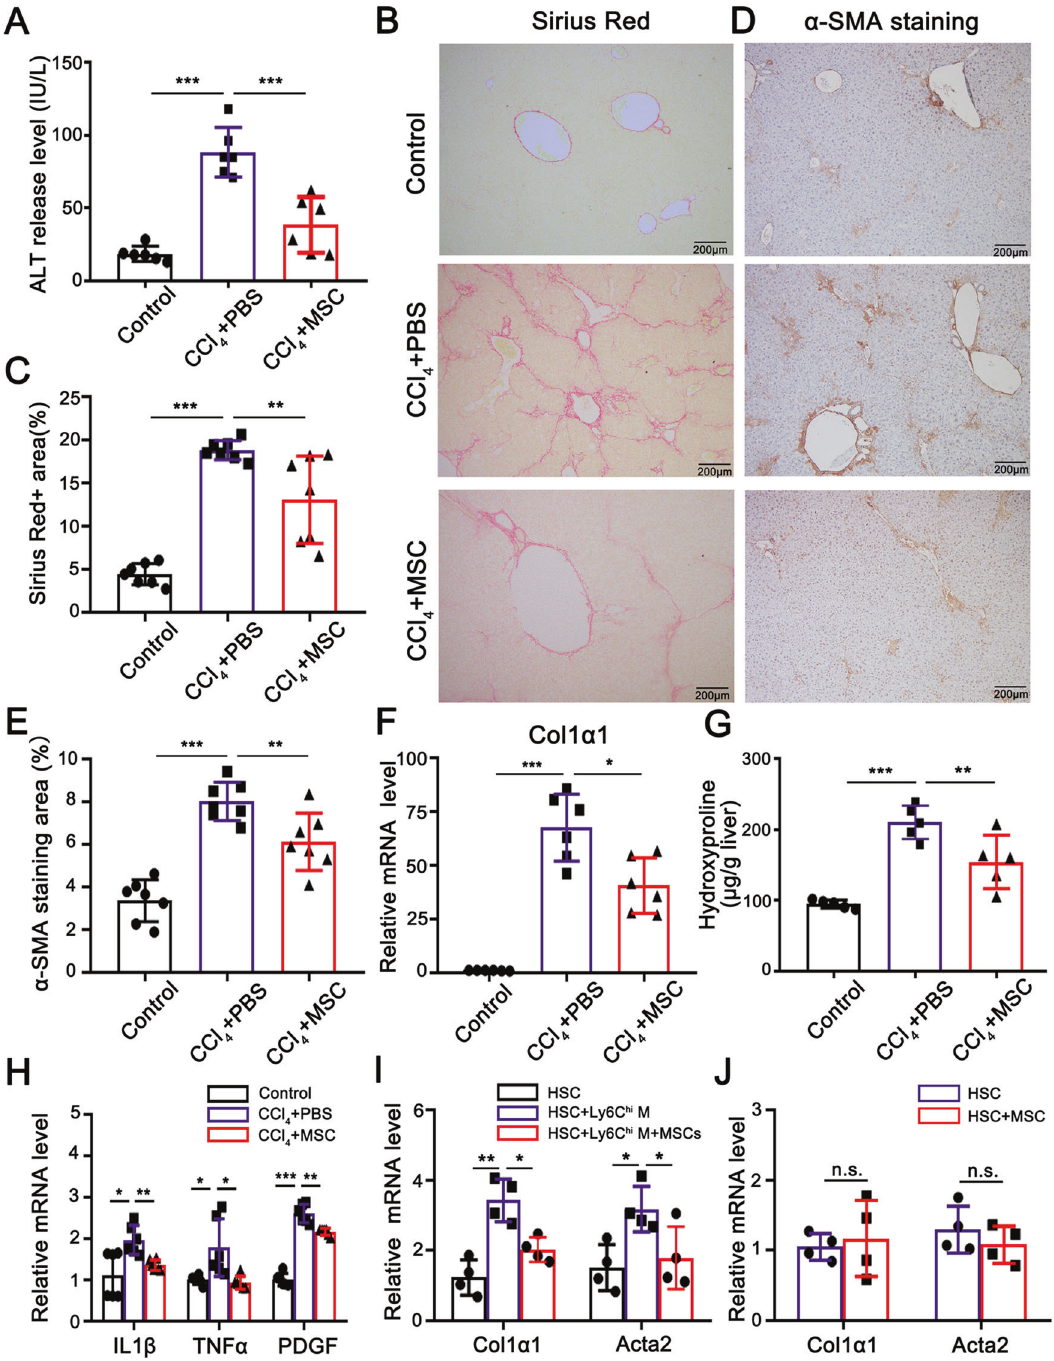
Fig. 1 BM-MSC transplantation attenuated CCl 4 -induced in fl ammatory levels and liver fi brosis. A ALT release level in the serum of normal control mice and fi brotic mice transplanted with BM-MSCs or PBS (control). Serum samples were collected at 2 weeks post-transplantation ( n = 6). B , C Liver tissue sections were stained with Sirius Red ( B ), and the degree of liver fi brosis was semi-quanti fi ed by Image software ( C ) ( n = 7). Scale bars, 200 μ m. D , E Immunohistochemistry staining of α -SMA in each group ( D ) and α -SMA + areas were semi-quanti fi ed by Image software ( E ) ( n = 7). Scale bars, 200 μ m. F Quanti fi cation of col1 α 1 mRNA expression levels related to GAPDH by quantitative real-time PCR ( n = 6). G Examination of hydroxyproline contents in livers at 2 weeks post-transplantation of BM-MSCs ( n = 5). H Relative expression levels of il- 1 β , tnf- α , and pdgf mRNAs in livers of normal control and fi brotic mice transplanted with BM-MSCs or PBS examined by quantitative real-time PCR ( n = 6). I Relative expression levels of col1 α 1 and acta2 mRNAs in HSCs, HSCs cocultured with Ly6C hi macrophages, and HSCs cocultured with Ly6C hi macrophages plus BM-MSCs examined by quantitative real-time PCR ( n = 4). Ly6C hi M is the abbreviation of Ly6C hi macrophages. J Relative expression levels of col1 α 1 and acta2 mRNAs in HSCs cocultured with BM-MSCs or without BM-MSCs (control) were examined by quantitative real-time PCR ( n = 4). Bars = means ± SD. Statistical evaluation of two groups was performed using an independent Student t -test. Statistical evaluation of multiple groups was performed using one-way ANOVA with posthoc LSD test; n.s. p > 0.05, * p < 0.05, ** p < 0.01, *** p < 0.001.